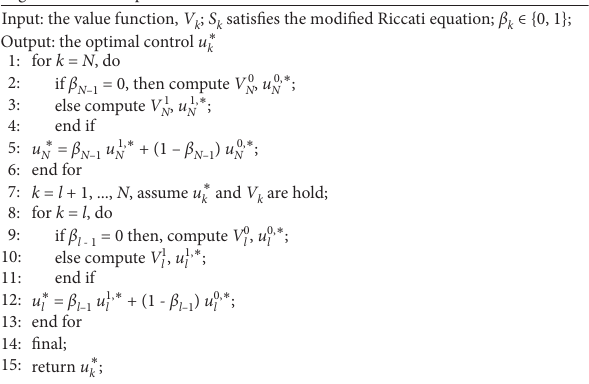
Algorithm 1 The Optimal Control Law